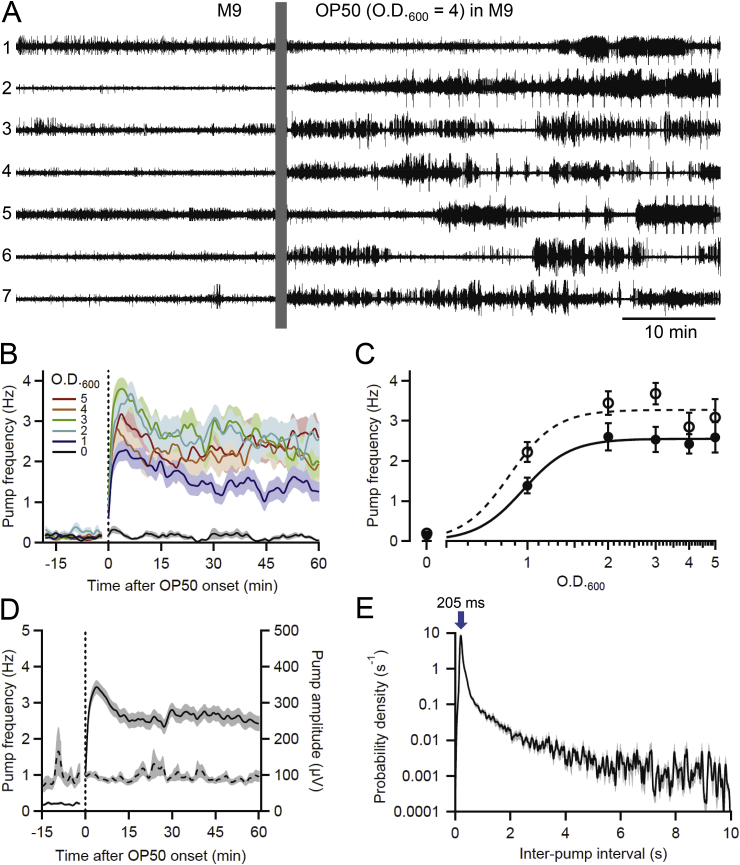
Stimulation of pharyngeal pumping by E. coli OP50. A. Representative example of simultaneous EPG recordings from seven N2 worms (numbered 1 to 7) in one chip; each trace from a different worm. Baseline activity recorded in M9 was followed by switching (vertical bar masks electrical artifact) to OP50 (O.D.600 = 4) in M9; the switch marked the termination of a 2-h period of food deprivation. Pumping increased and occurred in irregular bouts. Worms 1 and 5 were head-first in worm traps while the others were tail-first. B. Time course of pumping stimulation by OP50. Perfusate switch occurred at the vertical dotted line, with the electrical artifact blanked. Lines show mean pump frequency in worms perfused with OP50 at O.D.600 values between 0 (blank control) to 5 (n = 19–33 worms/group). Concentrations are denoted by color (see key). C. Concentration-response curves for rapid and sustained responses to OP50. Plots show mean pump frequency measured from t = 2–7 min (open circles and dashed line; rapid response) or t = 30–60 min (filled circles and solid line; sustained response) following the switch to OP50. The lowest OP50 concentration tested (O.D.600 = 1) evoked nearly half-maximal pump frequencies, which implies that C1/2 ≅ 1 mM for both rapid and sustained responses, but more data would be required to accurately constrain C1/2 and the Hill coefficient. The smooth curves in Fig. 3C, which are best fits to the Hill equation calculated assuming a Hill coefficient = 5, show saturating values of 3.37 Hz and 2.55 Hz for rapid and sustained responses, respectively. D. Effect of OP50 on pump frequency and amplitude. Data from worms perfused with OP50 between O.D.600 = 2–5 were combined and plotted as mean pump frequency (solid line) and peak-to-peak amplitude (dashed line; n = 90 worms). Switch to OP50 occurred at the vertical dotted line, with the electrical artifact blanked. E. IPI probability density histogram for worms perfused with OP50 between O.D.600 = 2–5, from t = 30–60 min (n = 90 worms). The mode of the distribution is marked (arrow; 205 ms, or 4.89 Hz). Plots in panels B-E are from the same groups of worms. Some error bars are smaller than the symbols. (For interpretation of the references to color in this figure legend, the reader is referred to the Web version of this article.)